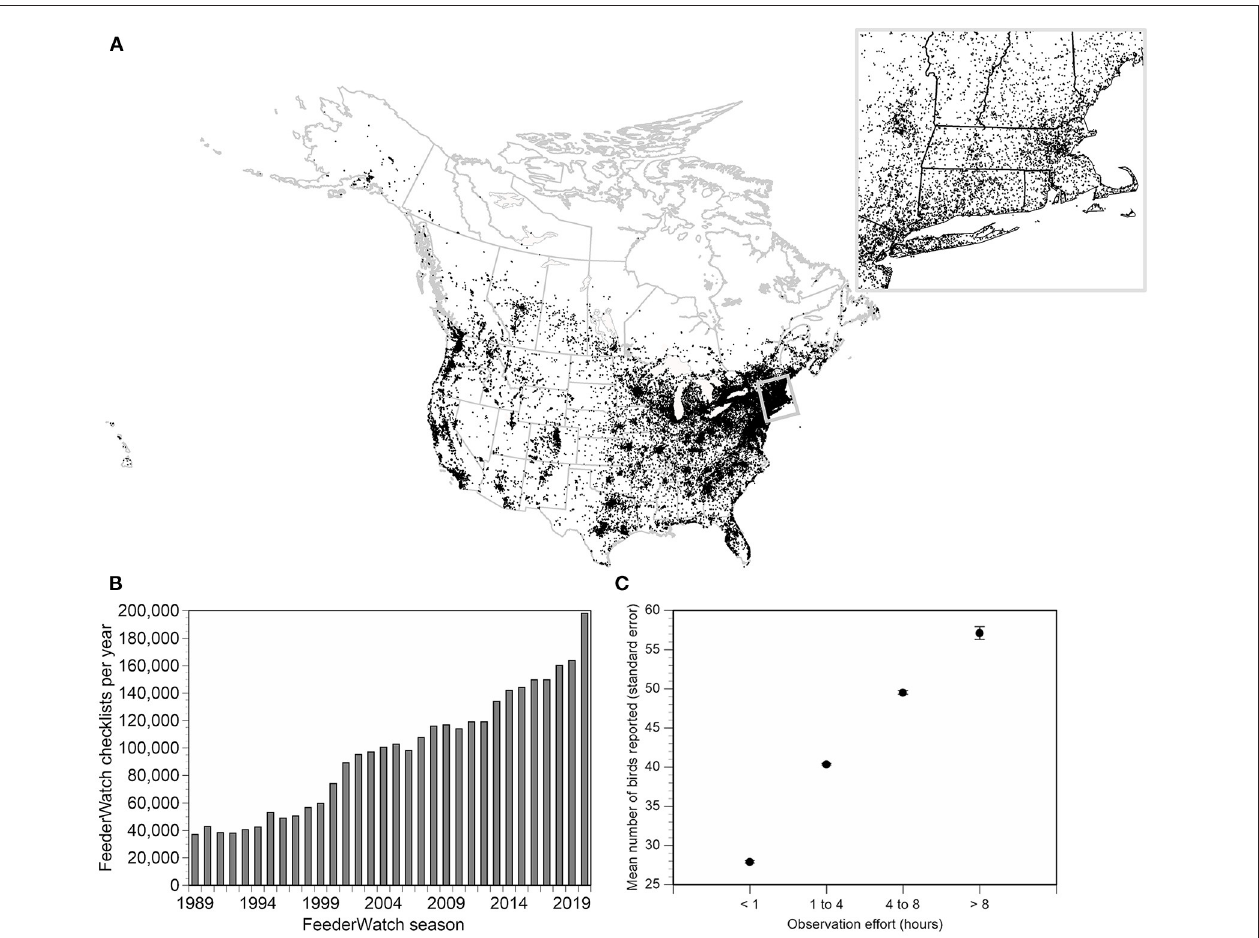
FIGURE 1 | (A) Map of locations from which Project FeederWatch participants have submitted data (all sites, 1989–2020, N = 65,237 locations). The inset box provides detail of an example area of northeastern North America to better illustrate the density of sampling locations. (B) Total number of checklists submitted to Project FeederWatch by year. (C) Mean ( ± standard error) number of birds reported per checklist as a function of observation effort (categorical: < 1h of effort, 1–4h, 4–8h, > 8h). All years and sites